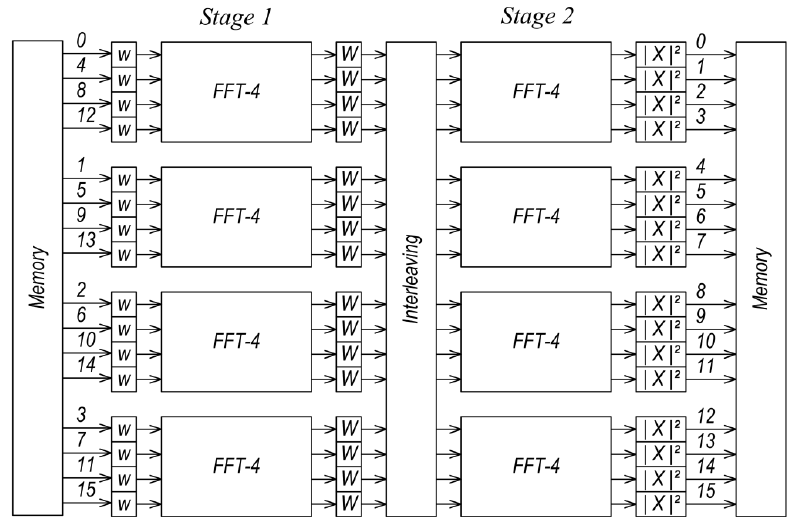
Fig. 3. Functional scheme of FFT-based MTI algorithm implementation, w denotes multiplication by the weighting coefficient, W denotes multiplication by the rotation coefficient.